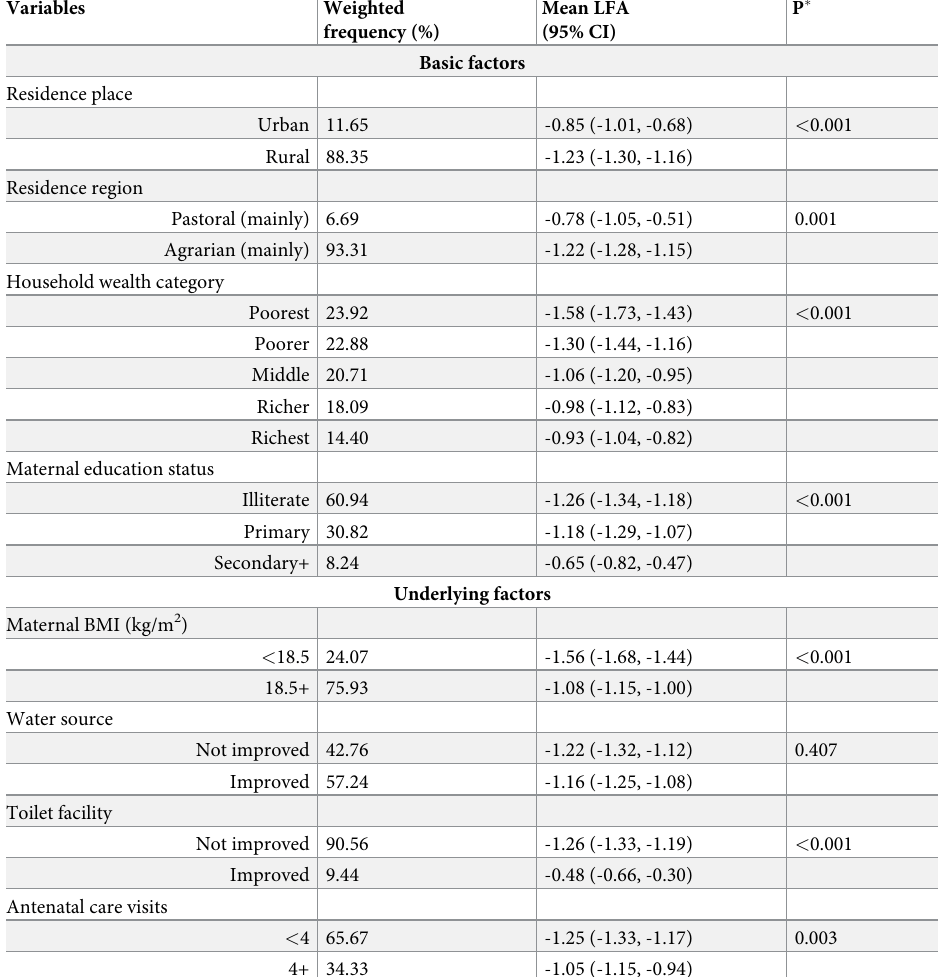
Table 1. Relation of basic and underlying factors with length-for-age (N =